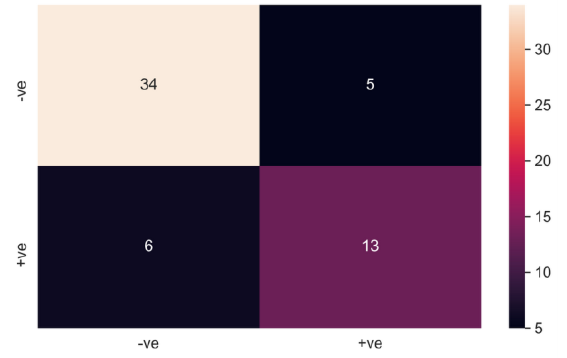
Figure 9. Confusion Matrix of Bagging Trees